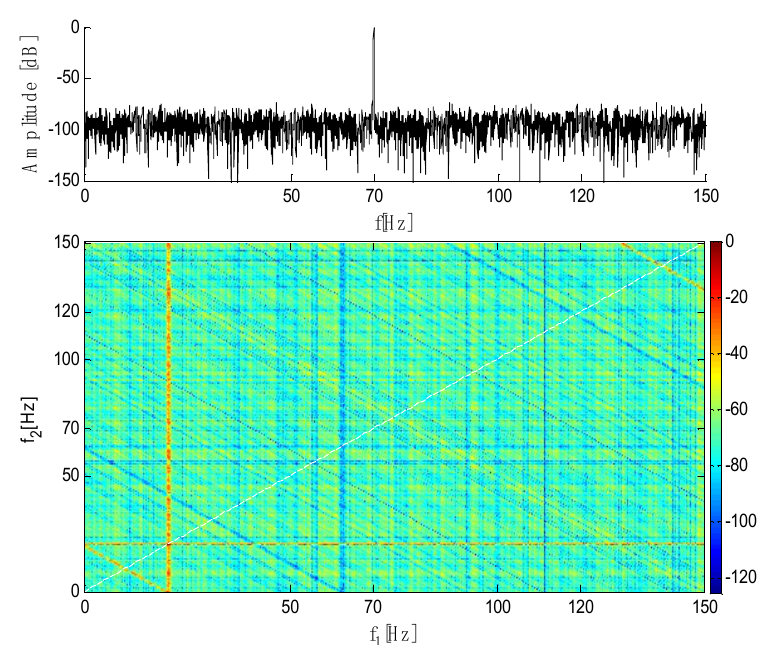
Figure 7. PS and bispectrum of the simulated signal x n ( t ), with additive white Gaussian noise (AWGN; signal-to-noise ratio (SNR) = 10 dB).